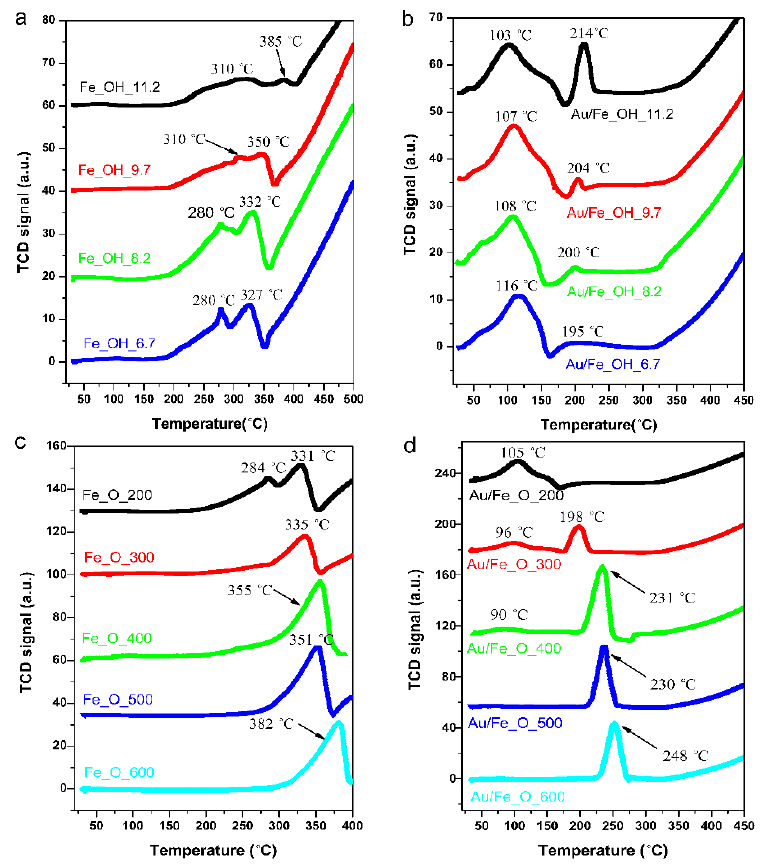
Figure 6. H 2 ‐ TPR profiles of fresh Au/FeO x catalysts: ( a ) Fe_OH; ( b ) Au/Fe_OH; ( c ) Fe_O; and ( d ) Au/Fe_O.